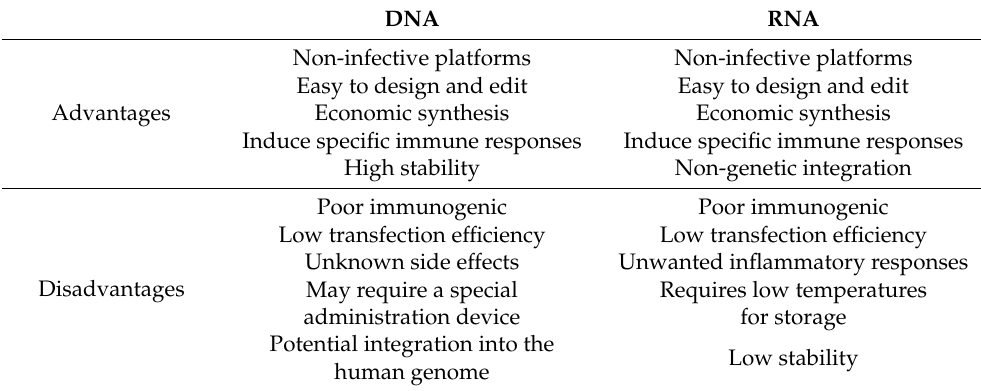
Table 3. Main advantages and disadvantages of non-viral vectors for cancer